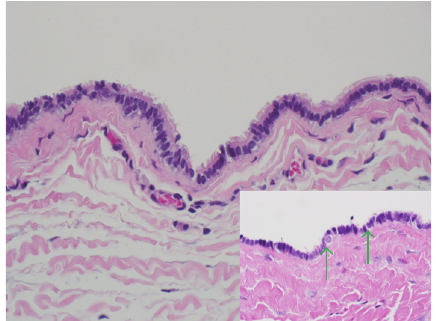
Figure 2: Higher magnification reveals that the cyst is lined by a ciliatedsimplecolumnarepitheliumreminiscentofthatofMullerian derived structures. H&E. Magnification, 400x. The inset highlights occasional cells with round nuclei and perinuclear clearing at the baseoftheepithelium(greenarrows).Thesecellsaresimilartothose seen in fallopian tube epithelium. H&E. Magnification,